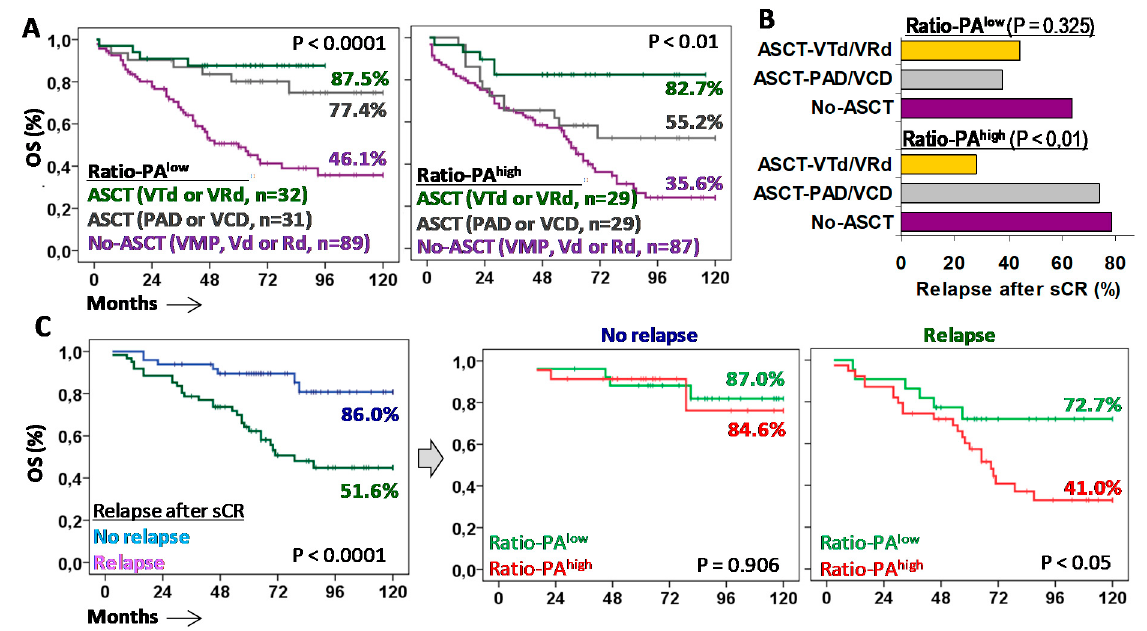
Figure 6. Autologous stem cell transplantation ( ASCT) with VTd or VRd is the only effective first-line treatment for MM patients with Ratio-PA high . ( A ) Kaplan-Meier and Log-rank tests for overall survival (OS) for patients with low or high Ratio-PA according to the type of first-line treatment: No-ASCT with VMP, Vd or Rd; ASCT with PAD or VCD; or ASCT with VTd or VRd. ( B ) Percentage of patients who relapsed after stringent complete response (sCR) with negative minimal residual disease (MDR-) for low or high Ratio-PA and the three types of treatments. ( C ) Kaplan-Meier and Log-rank tests for OS according to relapse after sCR, and according to the Ratio-PA.